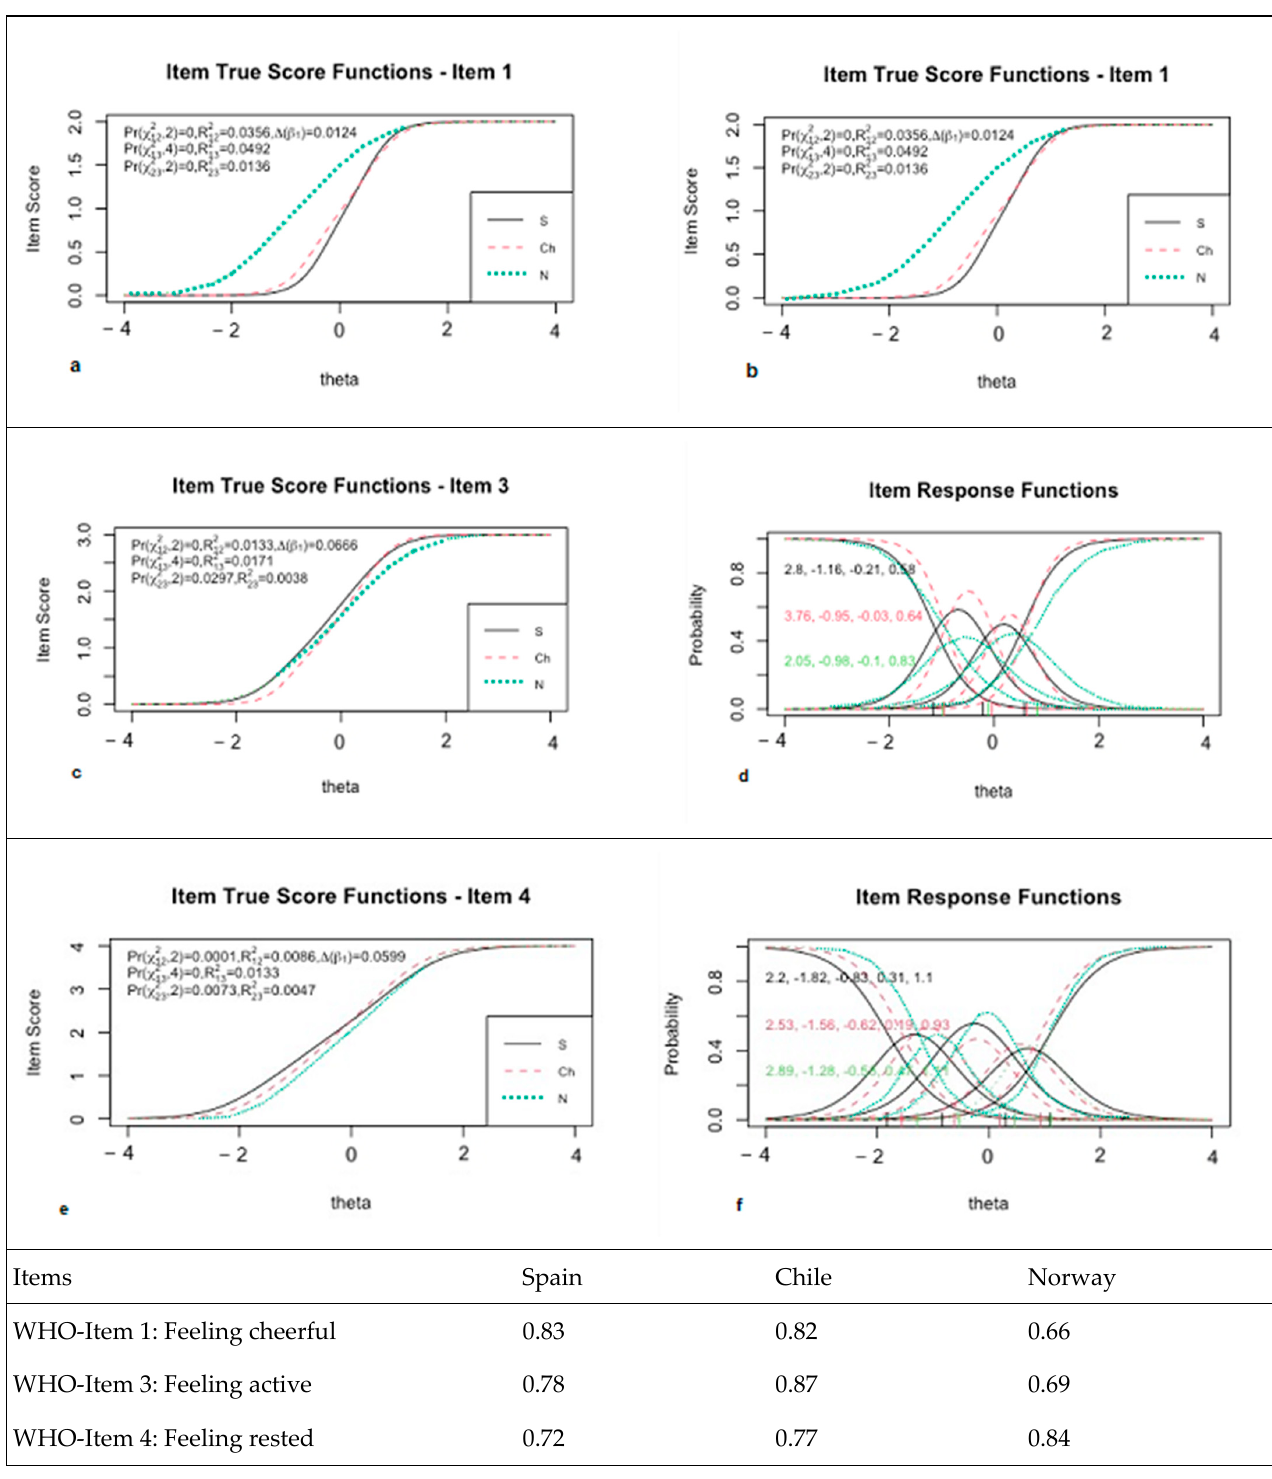
Figure 2. Item true score function with test for differential items functioning models (uniform vs. nonuniform) and item response function for Items 1 ( a , b ), 3 ( c , d ) and 4 ( e , f ) with regressions param- eters values by country.